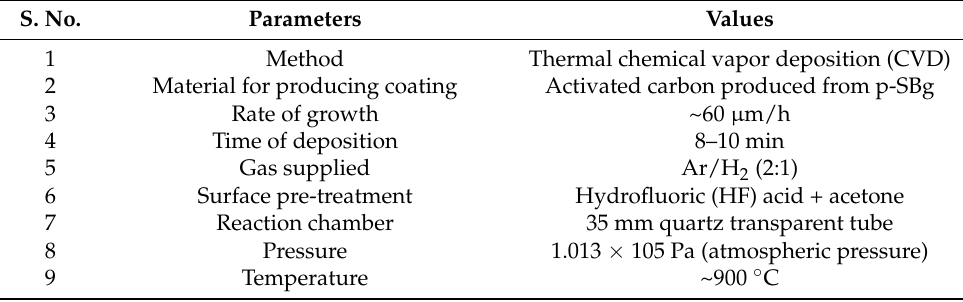
Table 1. Parameters and their values for the deposition of DLC coating. S.